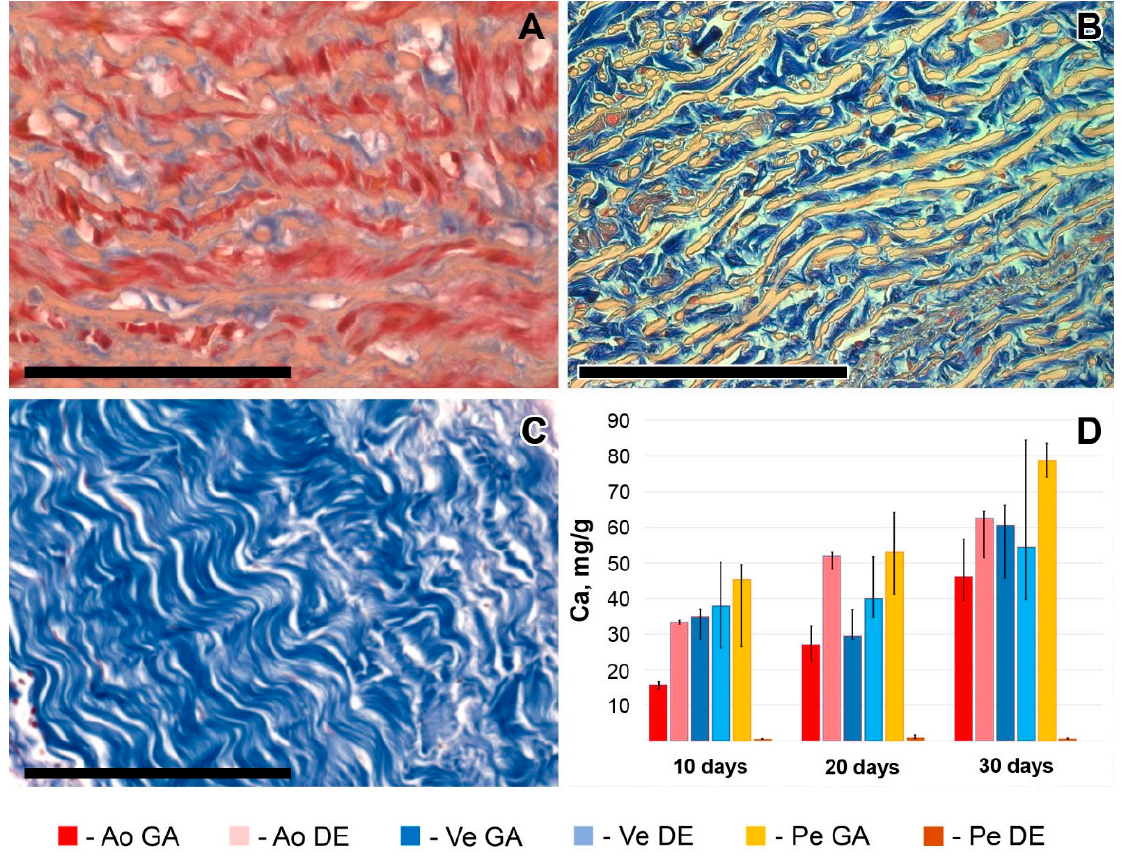
Figure 1. Different fresh biomaterial tissue structures: aortic wall ( A ), vein wall ( B ), and pericardium ( C ). Picro Mallory staining ( A – C ): collagen is blue, elastin is yellow, and smooth muscle cells are red. Scale bars are 100 µ m. Calcium content dynamics in these biomaterials are preserved with GA and DE ( D